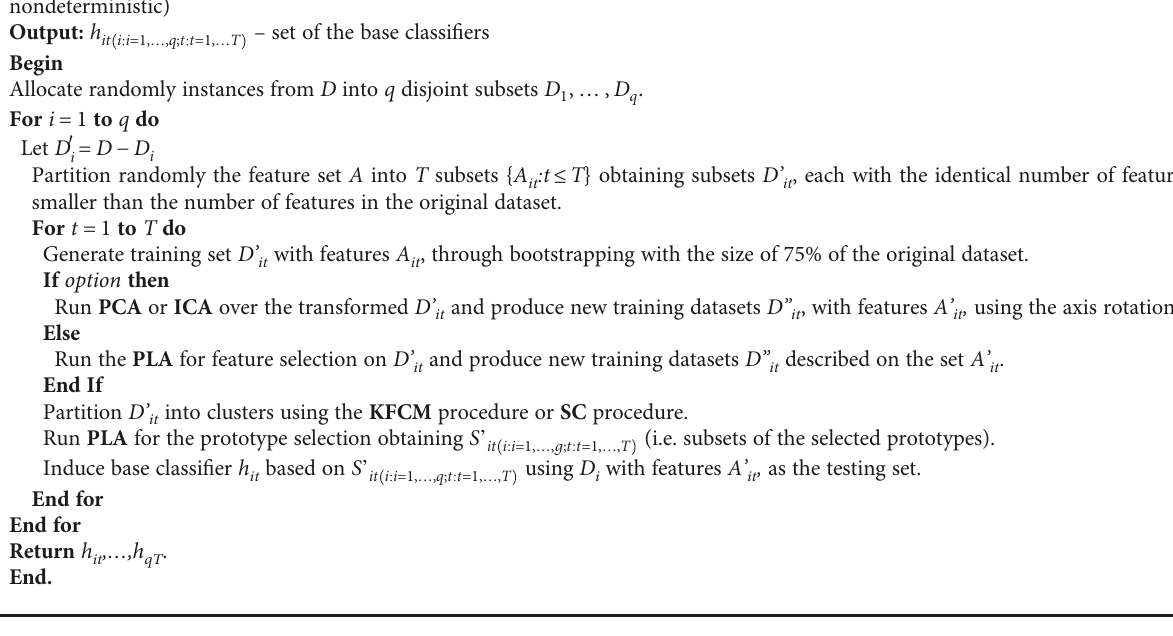
Algorithm 2: Stacked generalization with